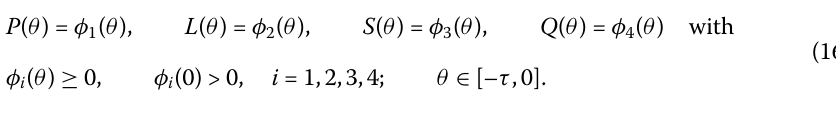
0.3495) loses stability and the specific case of system (2) experiences a Hopf